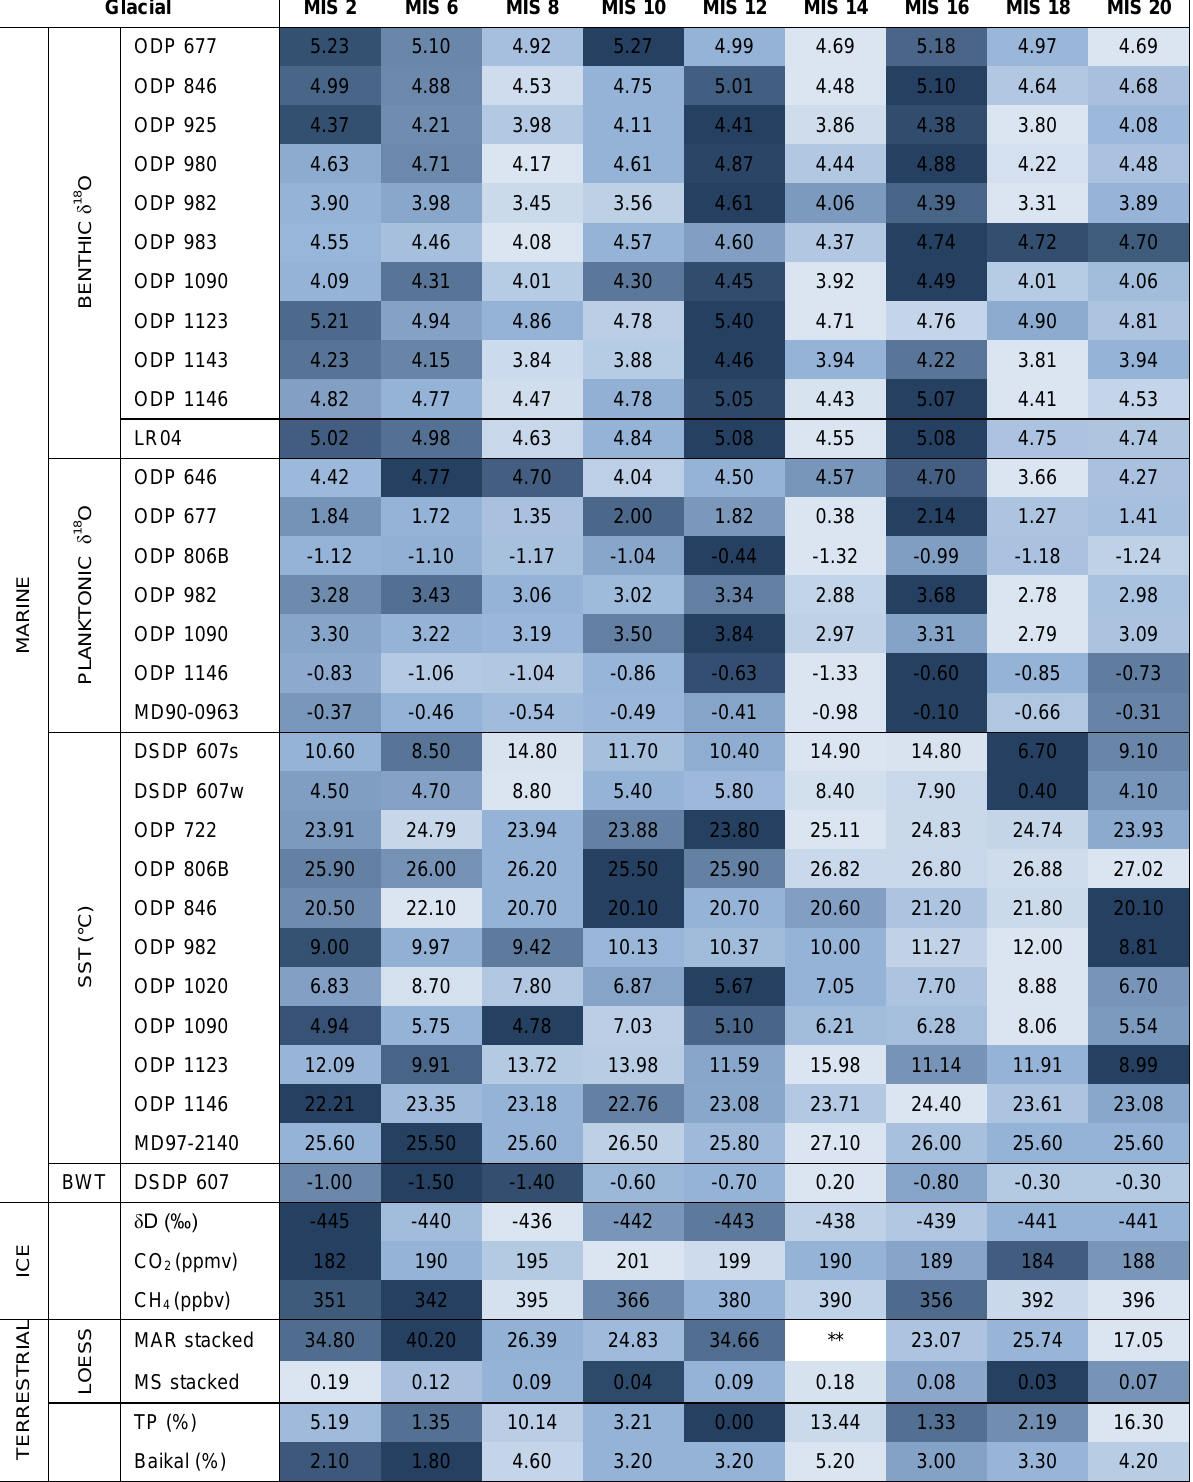
Table 4 - Maximum (pre-termination) values for each glacial. The values are colour-coded according to strength, with dark blue being the strongest, and pale blue the weakest, glacial signal for each palaeoclimate record.